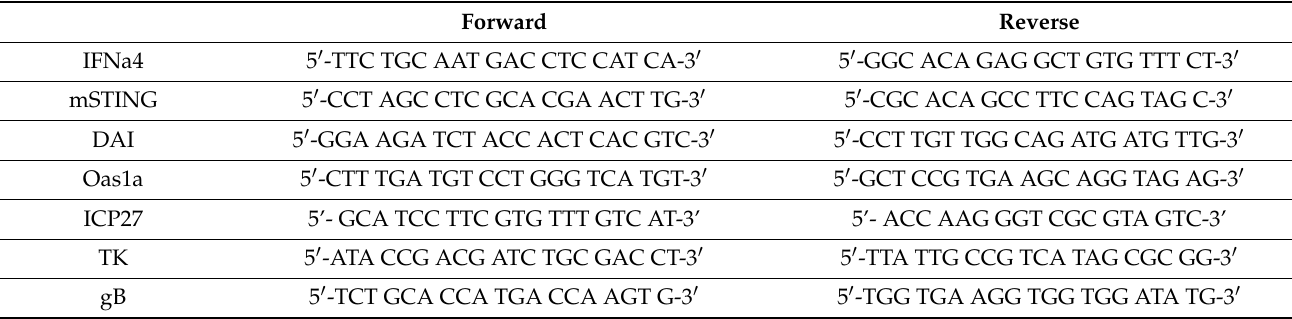
Table 1. Primer Sequences for Targeted